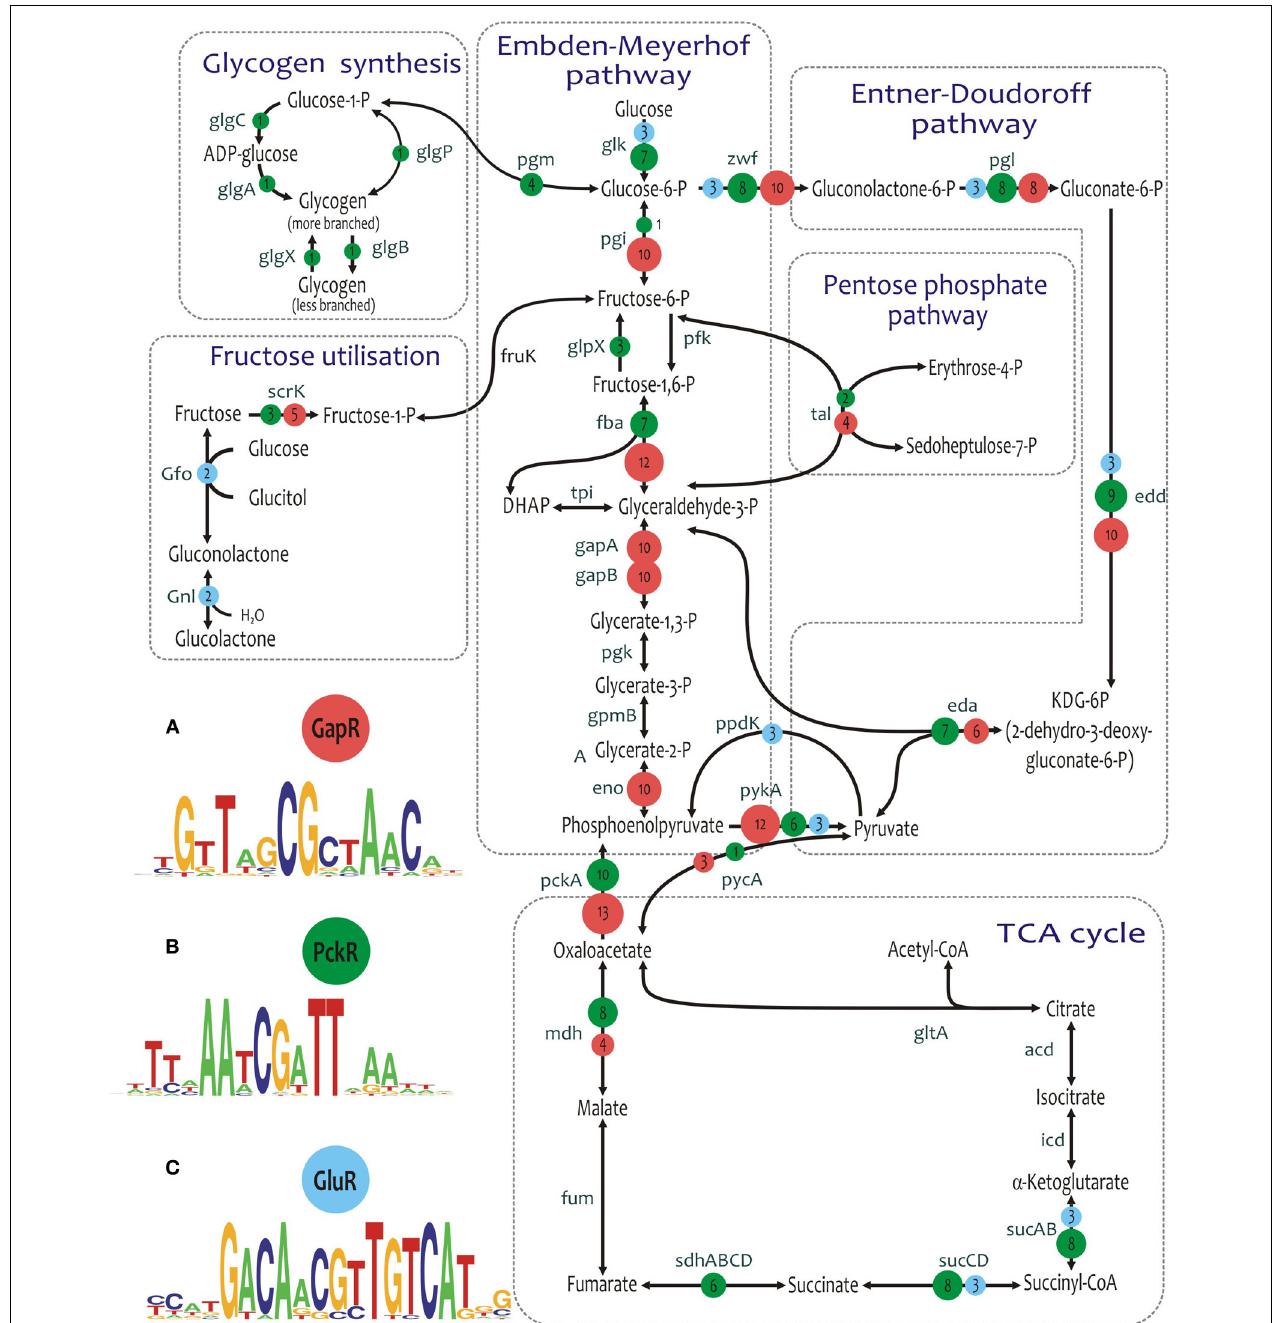
FIGURE 7 | Predicted global regulons for central carbohydrate metabolism in Alphaproteobacteria. (A) GapR regulon in Rhodobacteraceae. (B) PckR regulon in Rhizobiales. (C) GluR regulon